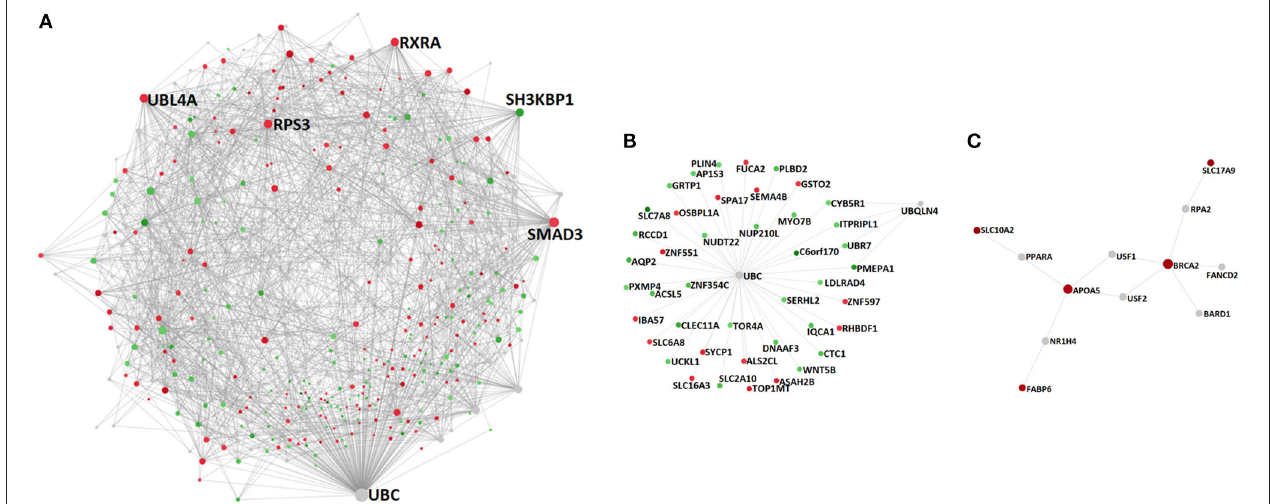
FIGURE 4 | PPI networks constructed upon the genes associated with differentially methylated promoters between non-diseased aortic and mitral valve tissue and the proteins that are necessary to interconnect them: (A) complete network, (B) subnetwork 1 ( p -value 3.04e-13) and (C) subnetwork 2 ( p -value 0.047). Depicted nodes are classified according to their methylation direction: nodes representing genes showing increased methylation in mitral compared to aortic tissue (red), nodes depicting increased methylation in aortic vs. mitral tissue (green) and nodes representing genes that are not part of the input dataset (gray). Node sizes are proportional to their betweenness centrality values. Betweenness centrality reflects the number of shortest paths passing through a node, while degree refers to the number of connections/edges/PPIs that a node has to other nodes. Hub nodes (A) UBC, SMAD3, UBL4A, RPS3, RXRA, (B) UBC and (C) BRCA2 and APOA5 can be clearly identified on the respective